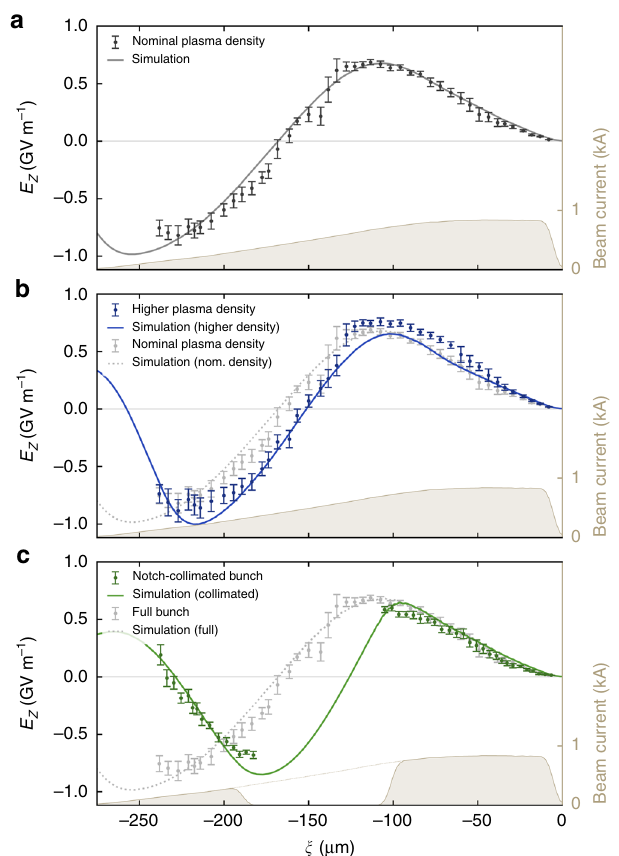
Fig. 4 Measured longitudinally averaged plasma wake fi elds. a The wake- fi eld of the nominal beam and plasma is sampled with a 6 μ m granularity. Error bars represent the shot-to-shot standard deviation. The solid line shows the corresponding PIC simulated wake fi eld. b The measurement is repeated with the same beam current pro fi le and an 80% higher plasma density (the beam arrives 1.7 μ s earlier), producing a shorter wavelength wake fi eld. c At the nominal density (same as in a ), the beam current is notch-collimated into a double-bunch pro fi le, producing a wake fi eld which is identical at the head, but strongly altered at the tail. The end point of ξ = − 240 μ m is determined by signal-to-noise